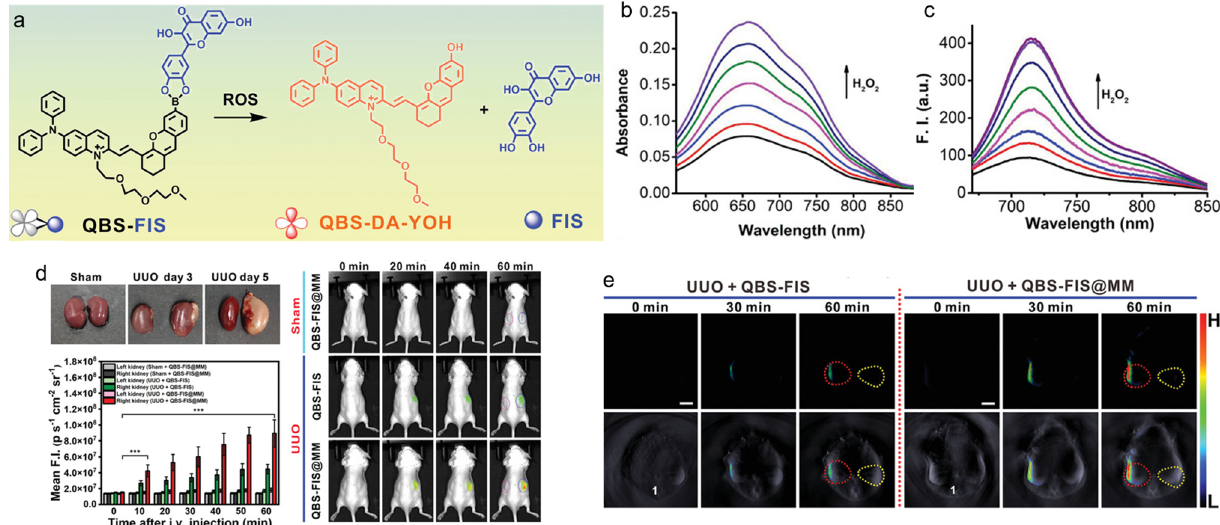
Figure 6. ( a ) Chemical structure and ROS response of the theranostic probe; ( b ) absorption and ( c ) PL spectra of QBS-FIS with the treatment of different concentrations of H 2 O 2 ; ( d ) fluorescence and ( e ) PA imaging of the sham-surgery and unilateral ureteral obstruction (UUO) mice with different treatments. *** p ≤ 0.001. (Reproduced with the permission from Ref. [121]. Copyright 2021, Wiley-VCH GmbH).